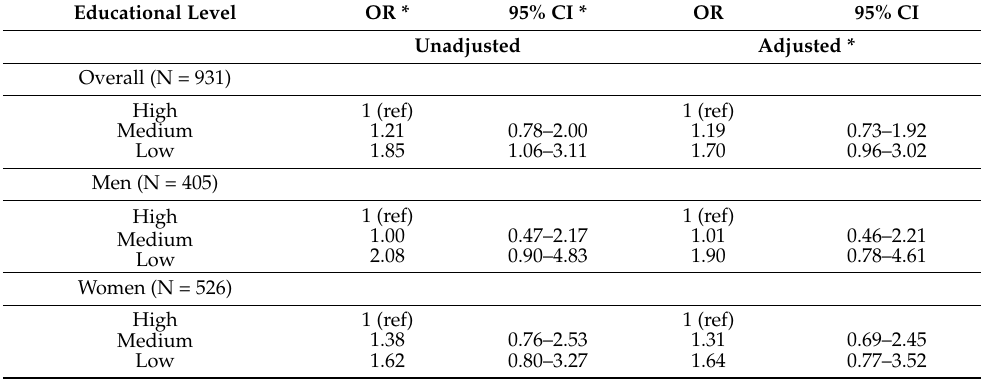
Table 2. Association between educational level and improvement in diet quality among adults in Madrid from 2017 to